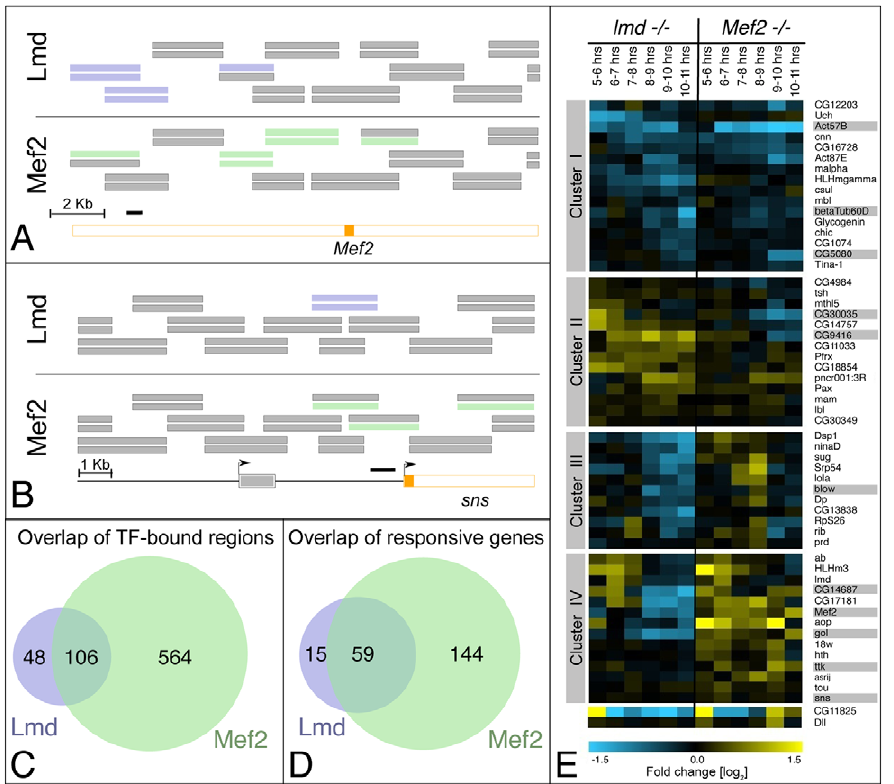
Figure 1. A global comparison of Lmd and Mef2 activity. (A) Schematic overview of a genomic region within an intron of the Mef2 locus: An exon (located on the antisense strand) is shown in orange. Genomic fragments on the tiling arrays are indicated as stacks of two horizontal bars in their corresponding genomic position. The top bar represents the results from the 6–8 hour (stages 10–11) ChIP-on-chip time point, the lower one corresponds to the 8–10 hour (stages 12–13) time point. Significantly enriched regions are indicated in blue for Lmd (top) and in green for Mef2 (bottom). The black bar indicates the location of the previously identified Lmd-binding site. Both Lmd and Mef2 are co-bound to genomic regions overlapping the known Lmd binding site at the 6–8 hr time point, as well as to other sites in this area. (B) Schematic overview of the genomic region upstream of the sns locus (exons show in orange): The known sns enhancer (black bar) partially overlaps with tiling array probes bound by Lmd (at both time points, blue bars) and Mef2 (at 8–10 hour time point, green bar). Additionally, Mef2 binds to other locations upstream and intronic of the sns locus. (C) Lmd and Mef2 co-occupy many genomic locations: Venn diagram displaying the number of non-overlapping regions significantly enriched in Lmd ChIPs (blue) and significantly enriched in Mef2 ChIPs at the same stages of development (green). Both factors co- occupy a large number of regions (overlap). (D) Co-regulation of common direct target genes by Lmd and Mef2: The majority of Lmd target genes (blue) are co-regulated by Mef2 (overlap), while Mef2 regulates a large number of additional genes (green). (E) Differential gene expression in lmd and Mef2 loss-of-function mutants [log 2 ]: differences in expression between mutant and wt embryos were recorded in a timecourse for lmd (left) or Mef2 (right) mutant embryos. Shown are all direct target genes of Lmd that are significantly misregulated at one or more time points in either mutant background (fold change . 1.6, q , 1%). K-means clustering was used to highlight similar downregulation (top) in both mutants, similar upregulation (centre) or divergent expression changes (bottom). Color scale indicates fold changes [log 2 ]. Genes studied in more detail are marked in grey.